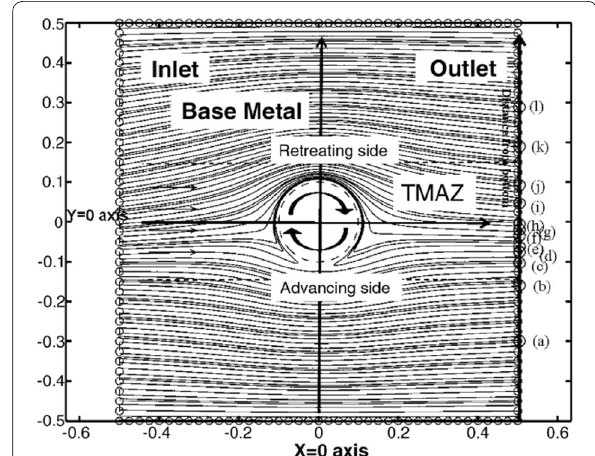
Figure 33 Flow of the material at the workpiece interface [124]